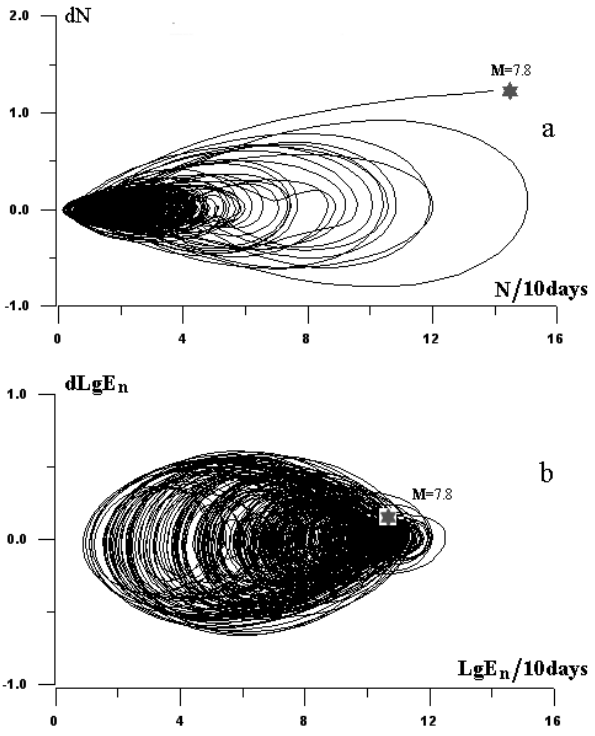
Fig. 9. Phase portrait of seismicity within a radius of 100km from the epicenter of the Kronotskoe earthquake for a 35-year period (1 January 1962–5 December 1997). The smoothed number N of Figure 9. Phase portrait of seismicity within a radius of 100 km from the epicenter of the 3 earthquakes (a) or energy LgEn, Joules (b) for 10 consecutive days Kronotskoe earthquake for a 35-year period (01.01.1962 – 05.12.1997). The smoothed number N 4 is marked on the X axis. Rates at which these parameters change of earthquakes (a) or energy Lg En , Joules (b) for 10 consecutive days is marked on the X axis. 5 ( dN or d LgEn), i.e. the difference between the following and the Rates at which these parameters change ( dN or d Lg En ), i.e. the difference between the following 6 preceding values are shown on the Y axis. The clockwise movement and the preceding values are shown on the Y axis. The clockwise movement along the curve 7 along the curve corresponds to an increase in time. The star marks corresponds to an increase in time. The star is mark the position of main shock. 8 the position of the main shock.